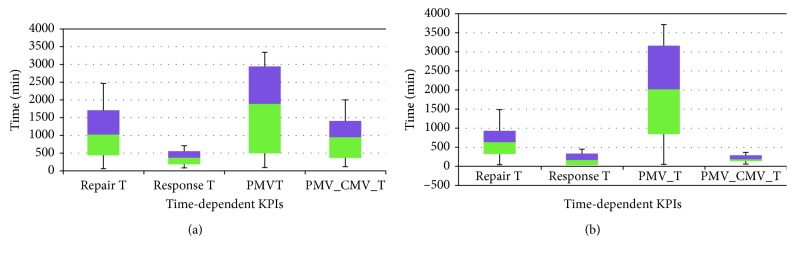
The box and whisker plot of four time-dependent KPIs: (a) before OpenMEDIS and (b) after OpenMEDIS.